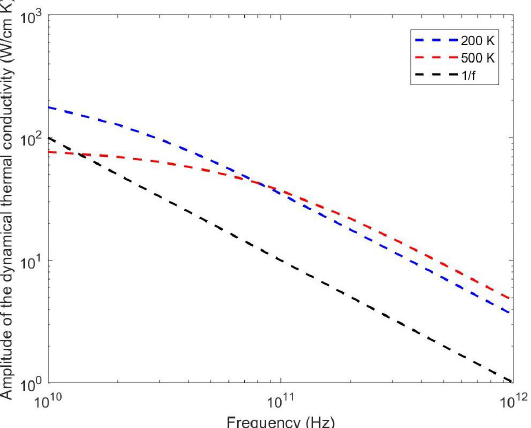
Figure 7. Amplitude of Si thermal conductivity for f going from 10 GHz to 1 THz at T = 200 K and T = 500